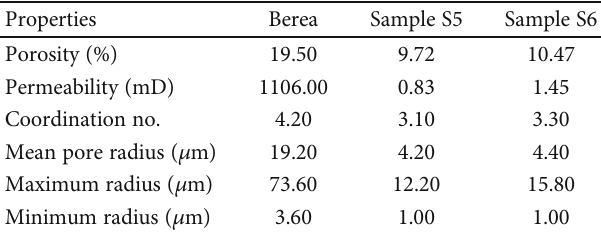
Table 1: Properties of the three experimental samples.